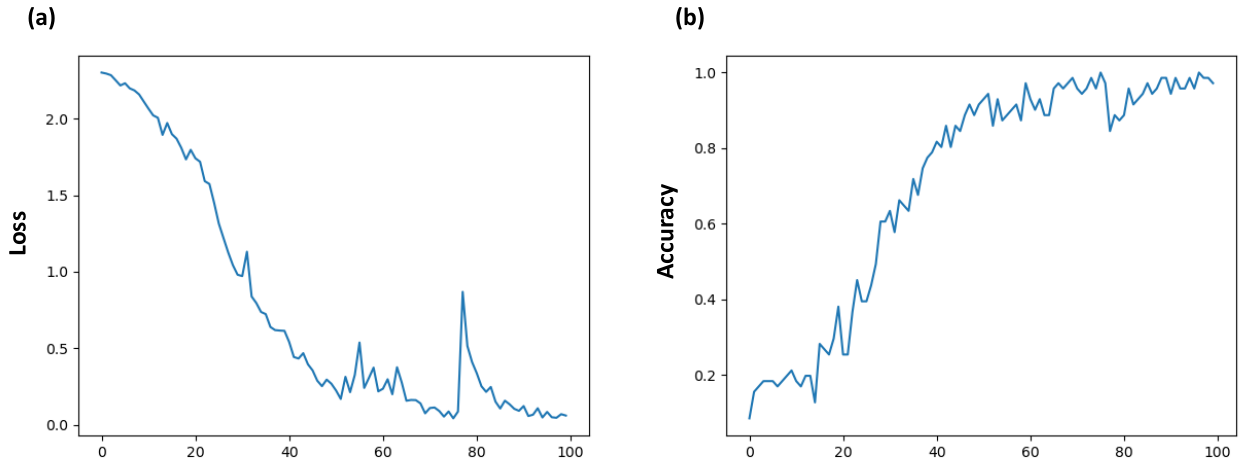
Figure 12. LSTM performance of the training phase (the training dataset is the 80% of the whole dataset): ( a ) Loss trend versus epoch number. ( b ) Accuracy trend versus epoch number.